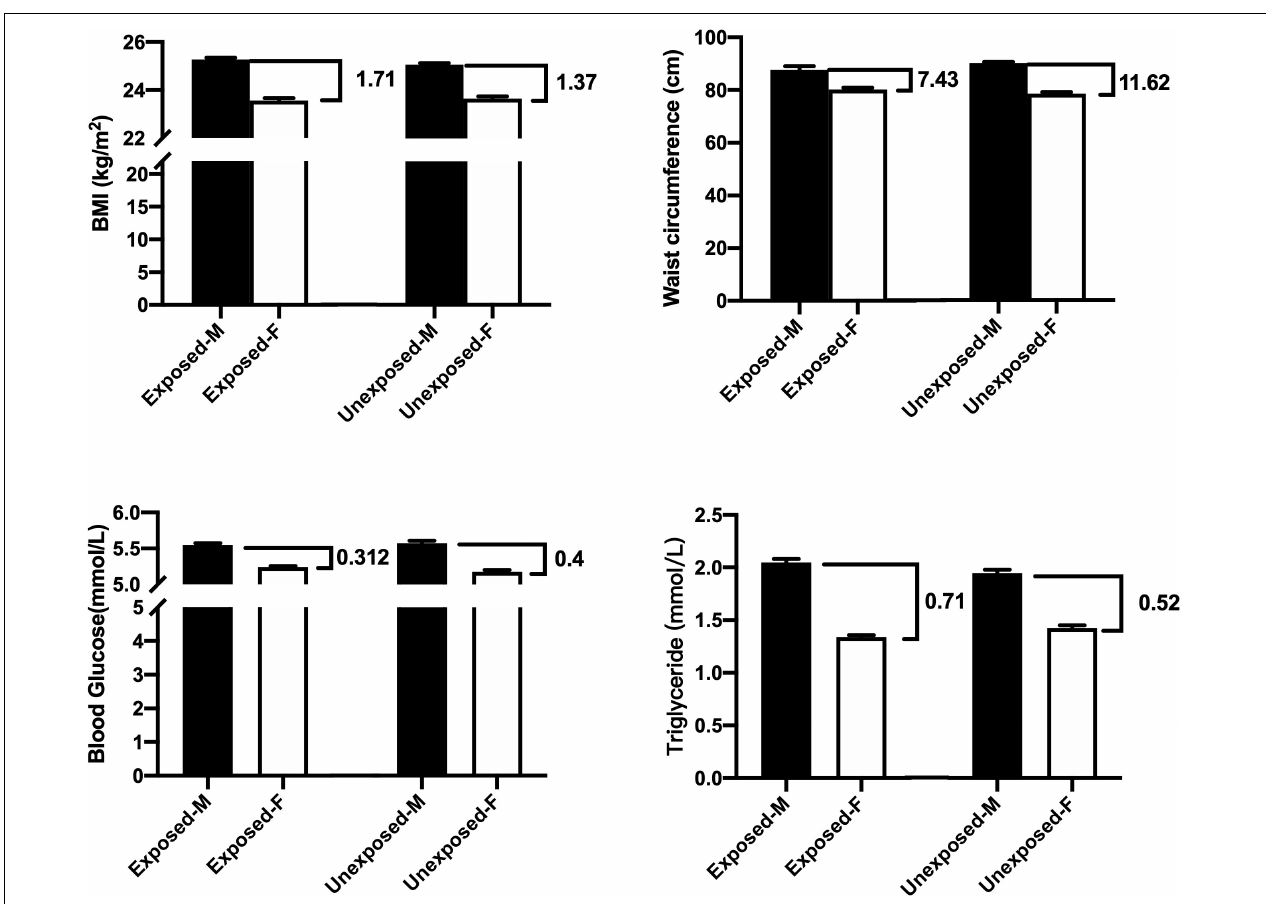
FIGURE 1 | Comparisons between the exposed-M (male) and exposed-F (female) as well as between unexposed-M and unexposed-F ( t